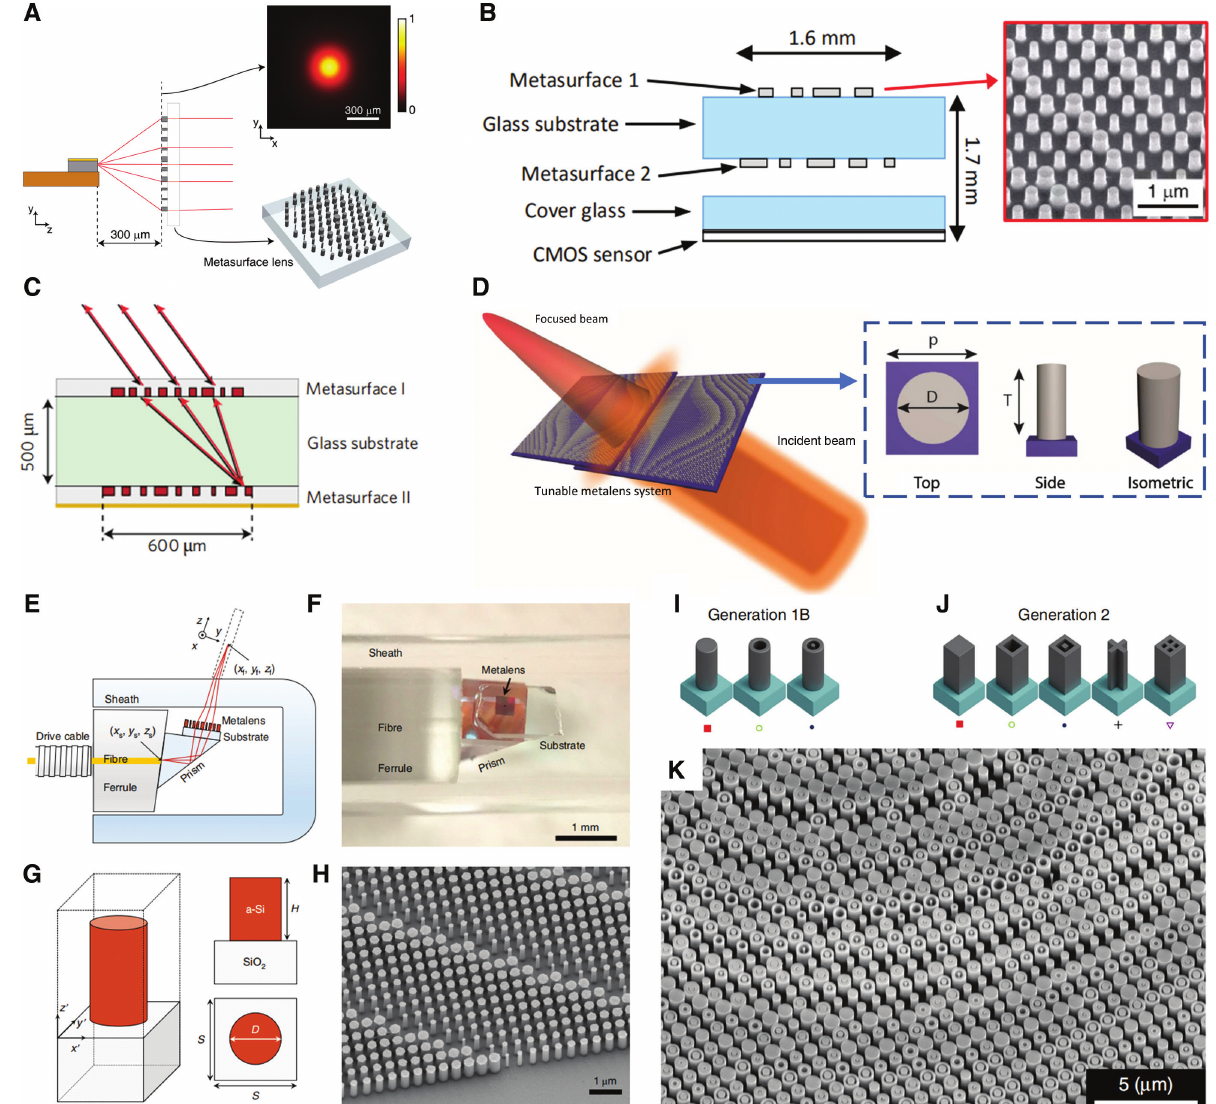
Figure 4: Applications of isotropic nanostructured metasurfaces with varied dimensions. (A) Beam collimator for mid-IR quantum cascade lasers [29]. (B) Fisheye lens with large F-number and wide FOV [30]. (C)